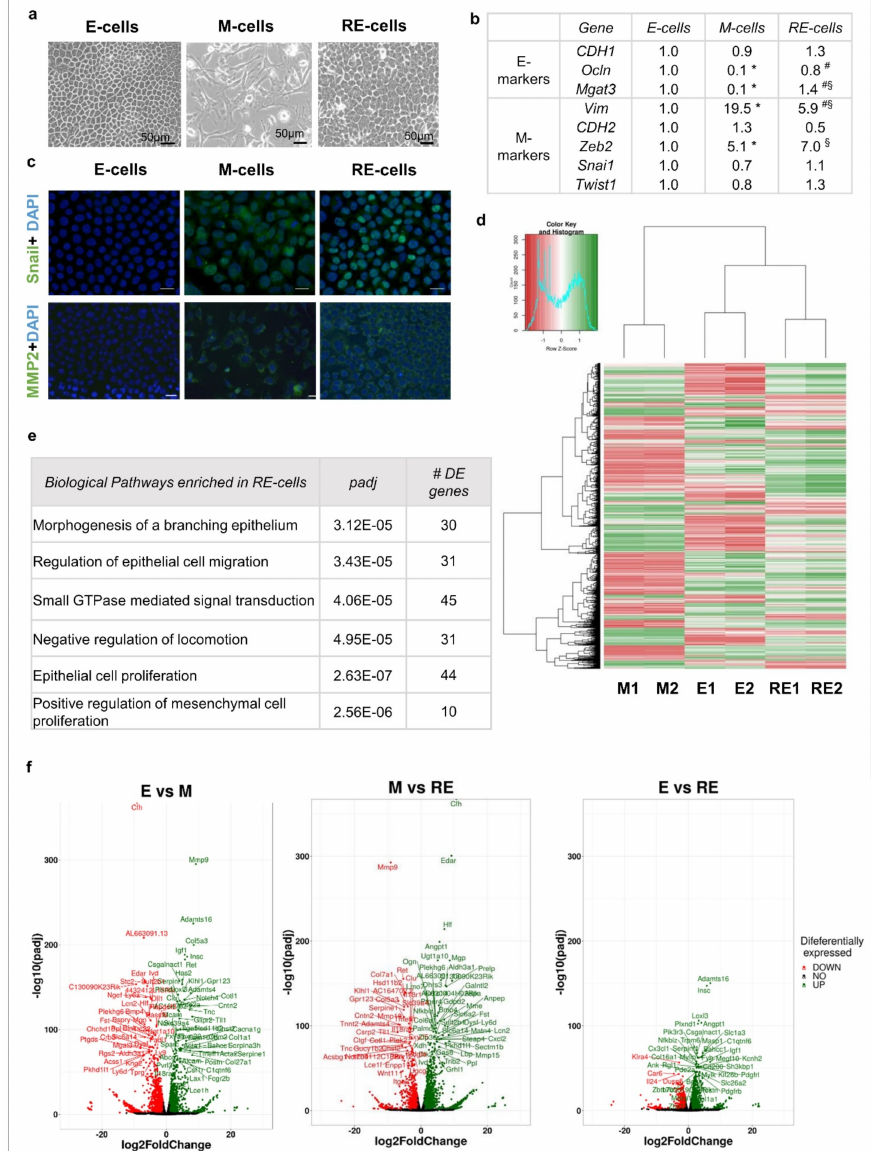
Figure 1. The RE cells underwent MET and displayed a transcriptomic signature that partially resembled E cells. ( a ) Brightfield images of E, M and RE cells. ( b ) RNA expression analysis of EMT-associated markers in E, M and RE-cells (qRT-PCR, where data were analysed using the Mann– Whitney test; * = p < 5.00 × 10 − 2 for E vs. M cells, § = p < 5.00 × 10 − 2 for E vs. RE cells and # = p < 5.00 × 10 − 2 for M vs. RE cells). ( c ) Immunofluorescence staining for Snail, MMP2 and DAPI as indicated. RE cells showed strong staining for both Snail and MMP2, indicating that they retained M features. ( d ) Heat map of differentially expressed genes assessed by RNAseq (0.6 > fold change > 1.5, p < 1.00 × 10 − 2 ). Z-scored values expressed from − 1 to 1 (from red to green, representing low to high expression levels, respectively). M1 and M2 = M cell reps 1 and 2, E1 and E2 = E cell reps 1 and 2 and RE1 and RE2 = RE cell reps 1 and 2. ( e ) Significantly enriched biological pathways derived from the 1288 differentially expressed genes specific to RE cells. ( f ) Volcano plots highlighting the differentially expressed genes in all the comparisons among the different cell